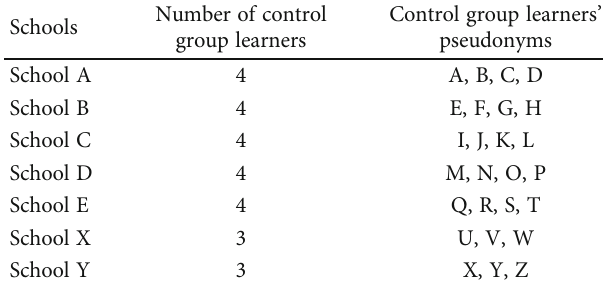
Table 1: Distribution of control group